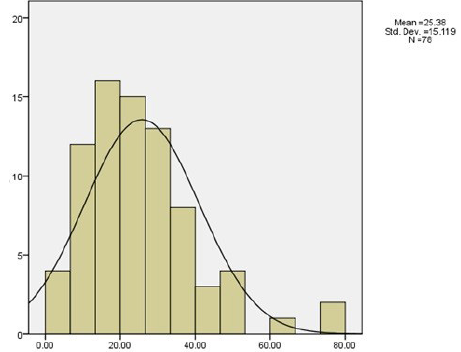
Figure 2. The diameter of the jugular vein during resuscitation (horizontal) by frequency (vertical).